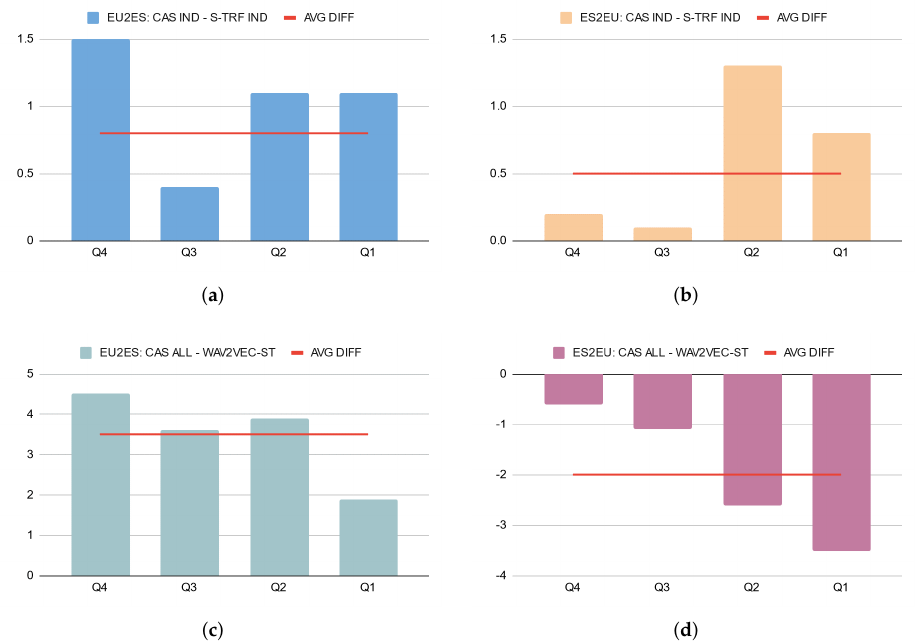
Figure 3. BLEU score differences on WER-based quartile subsets of the mintzai-ST test sets, between: ( a ) CAS IND and S - TRF . PT . KD IND in EU-ES ( b ) CAS IND and S - TRF . PT . KD IND in ES-EU, ( c ) CAS ALL and WAV 2 VEC - ST . PT in EU2ES, and ( d ) CAS ALL and WAV 2 VEC - ST . PT in ES2EU. The red line indicates the average difference over joint subsets. Quartiles range from lower WER (Q4) to higher WER